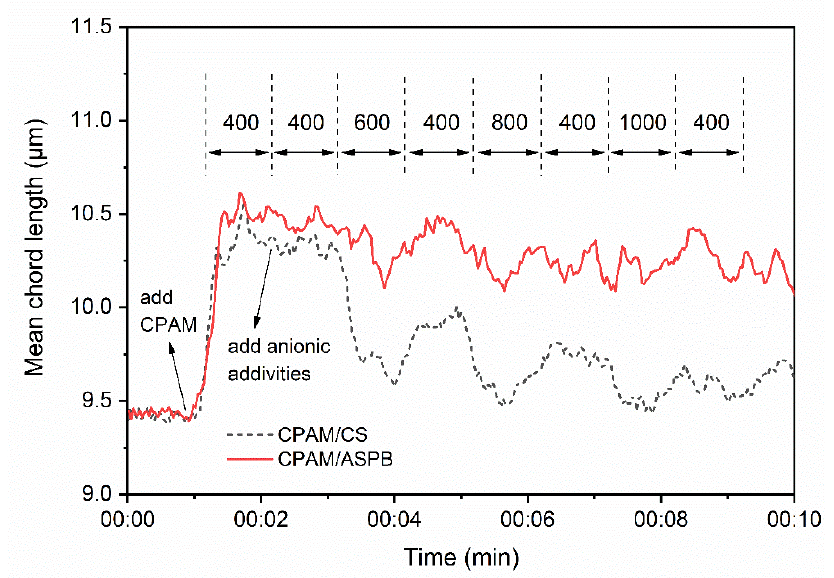
Figure 6. Mean chord length of pulp suspension induced by two different dual-component systems at the optimum flocculant dosage.